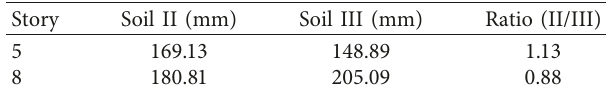
Figure 12: Maximum floor displacement variations of (a) 5-story and (b) 8-story frames under near-field records. Table 9: Average of maximum floor displacement under near-field